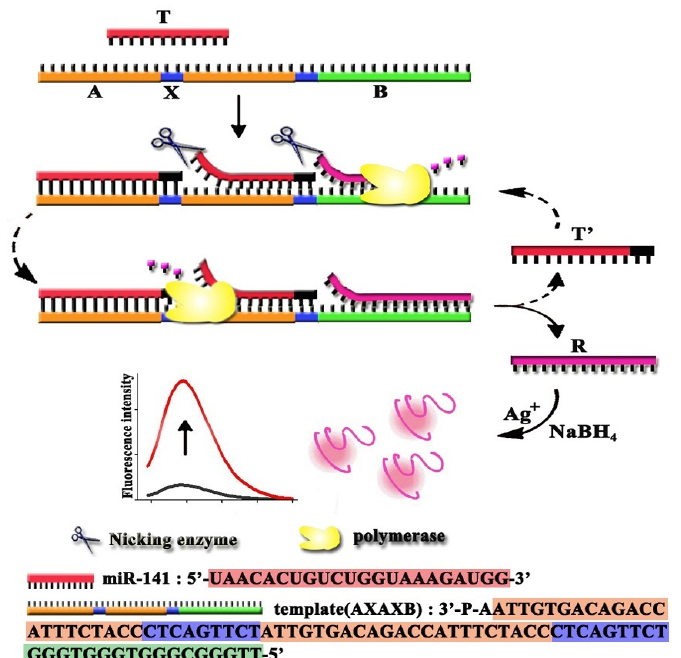
Figure 1. Detection of miRNA with attomolar sensitivity based on target-assisted isothermal exponential amplification (TAIEA) coupled with fluorescent DNA scaffolded AgNC probe. Reprinted with permission from [21]. Copyright 2012 American Chemical Society.